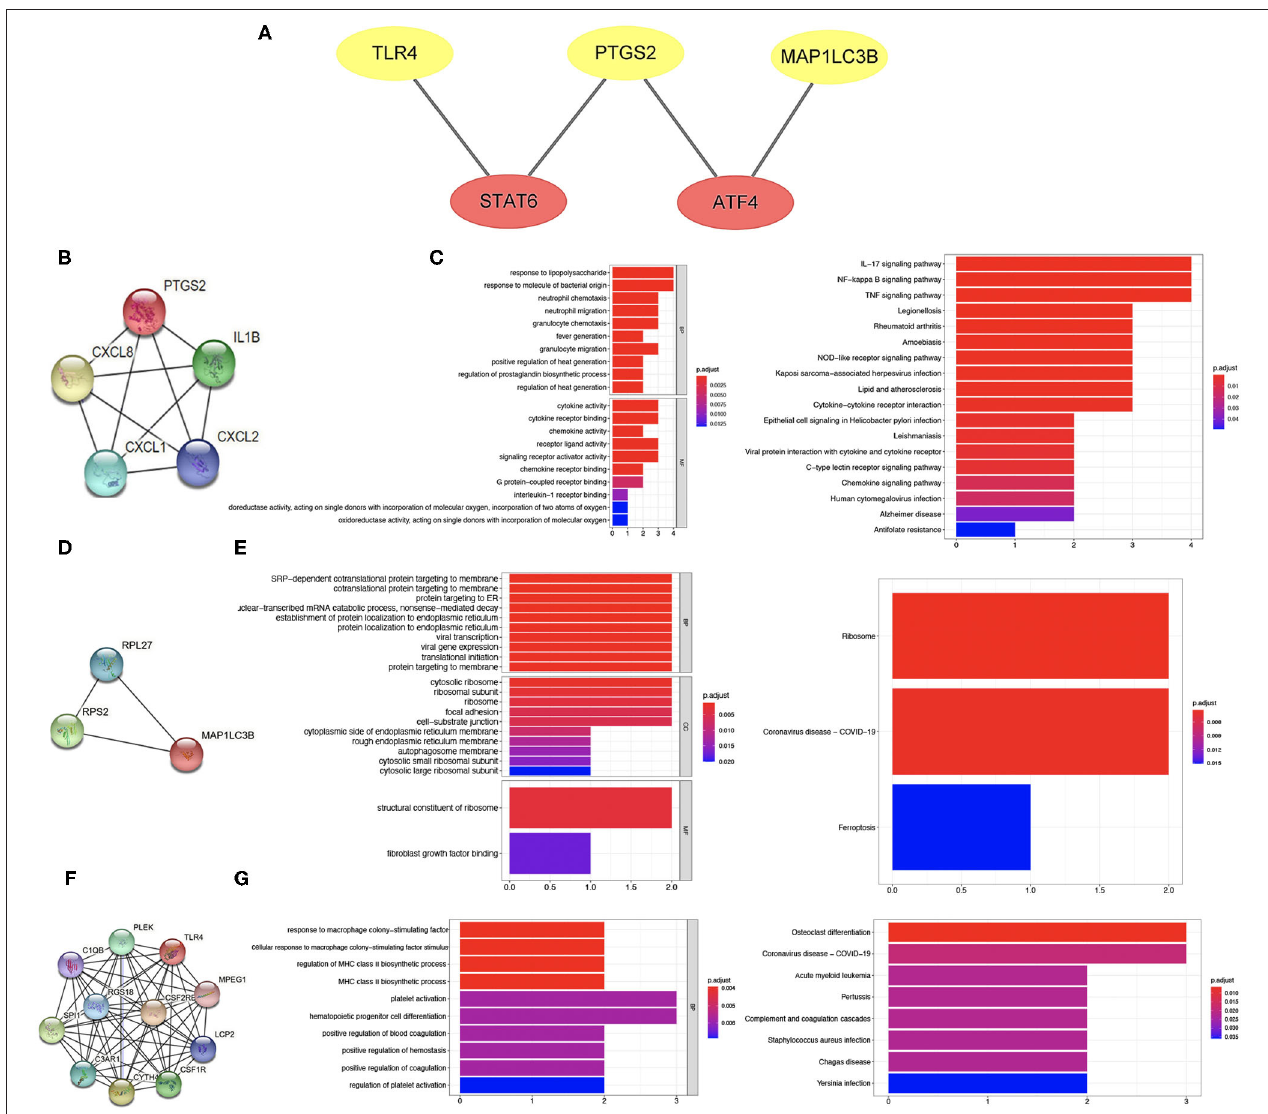
FIGURE 8 | Transcription factor regulation network and co-expressed protein network of ferroptosis-related biomarkers. (A) Transcription factor regulation network of ferroptosis-related biomarkers. (B,C) Co-expressed protein network of PTGS2 and enriched items in GO and KEGG analysis. (D,E) Co-expressed protein network of MAP1LC3B and enriched items in GO and KEGG analysis. (F,G) Co-expressed protein network of TLR4 and enriched items in GO and KEGG